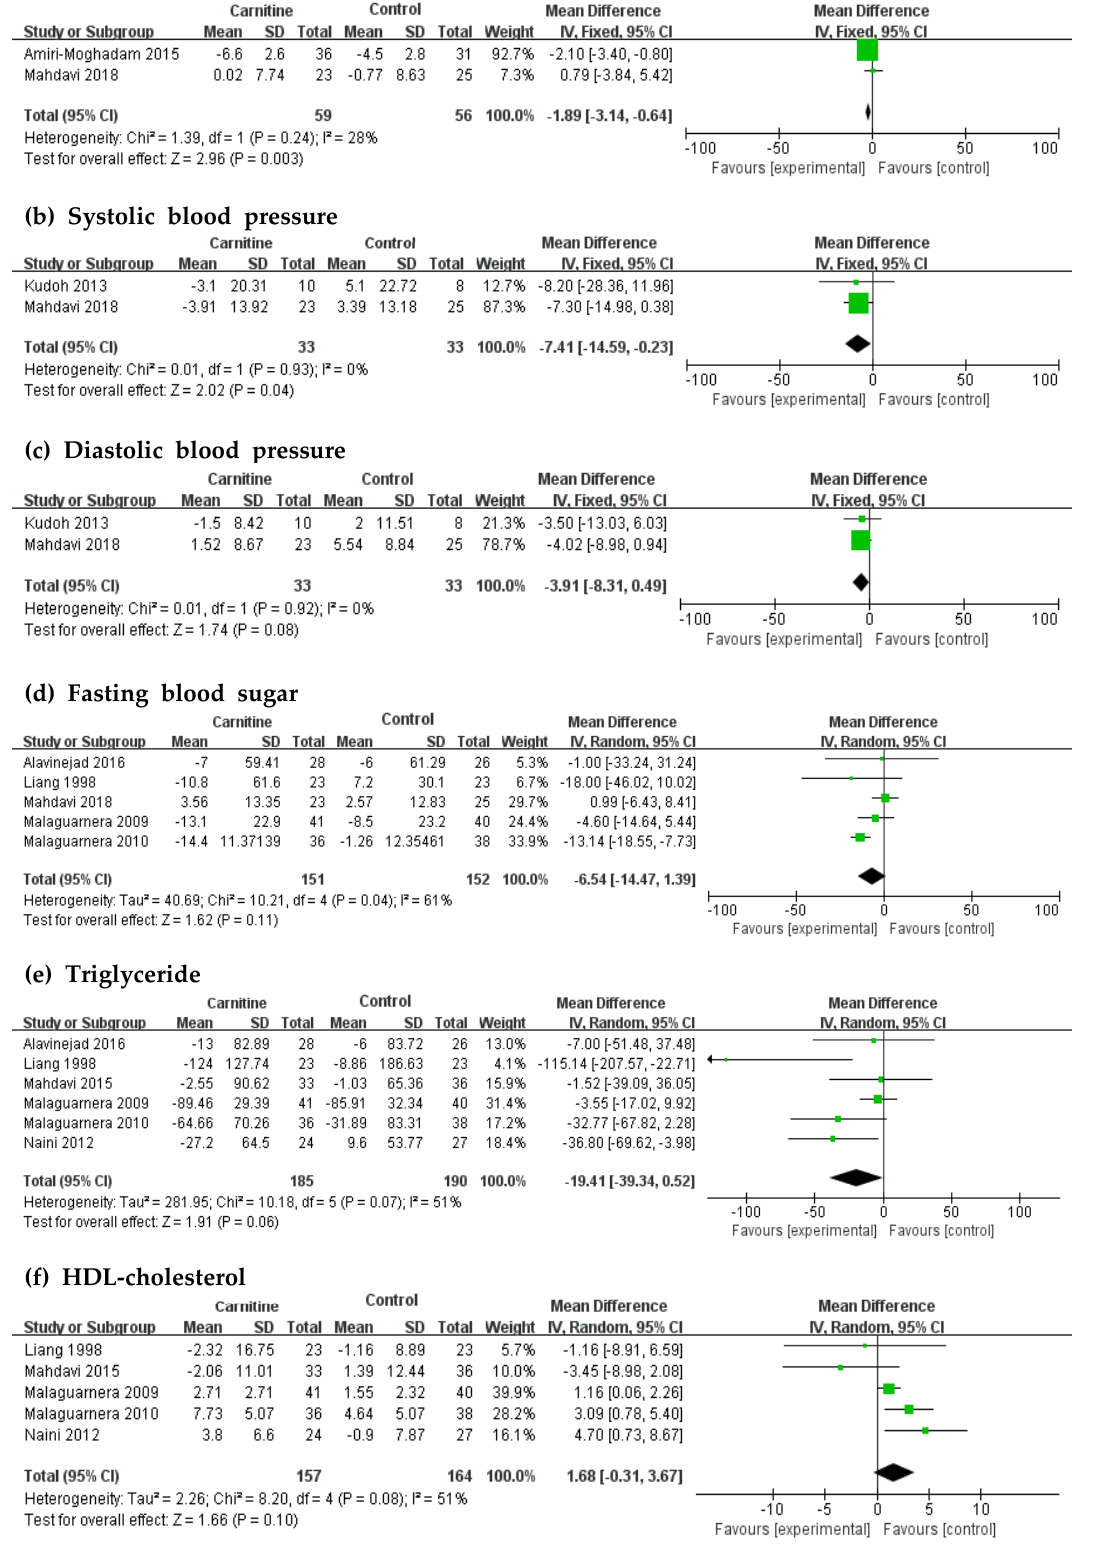
Figure 3. Forest plots of waist circumference ( a ), systolic blood pressure ( b ), diastolic blood pressure ( c ), fasting blood sugar ( d ), triglyceride ( e ), and HDL-cholesterol ( f ). Abbreviations: SD: standard deviation, IV: inverse variance, CI: confidence interval; HDL-Cholesterol: High density